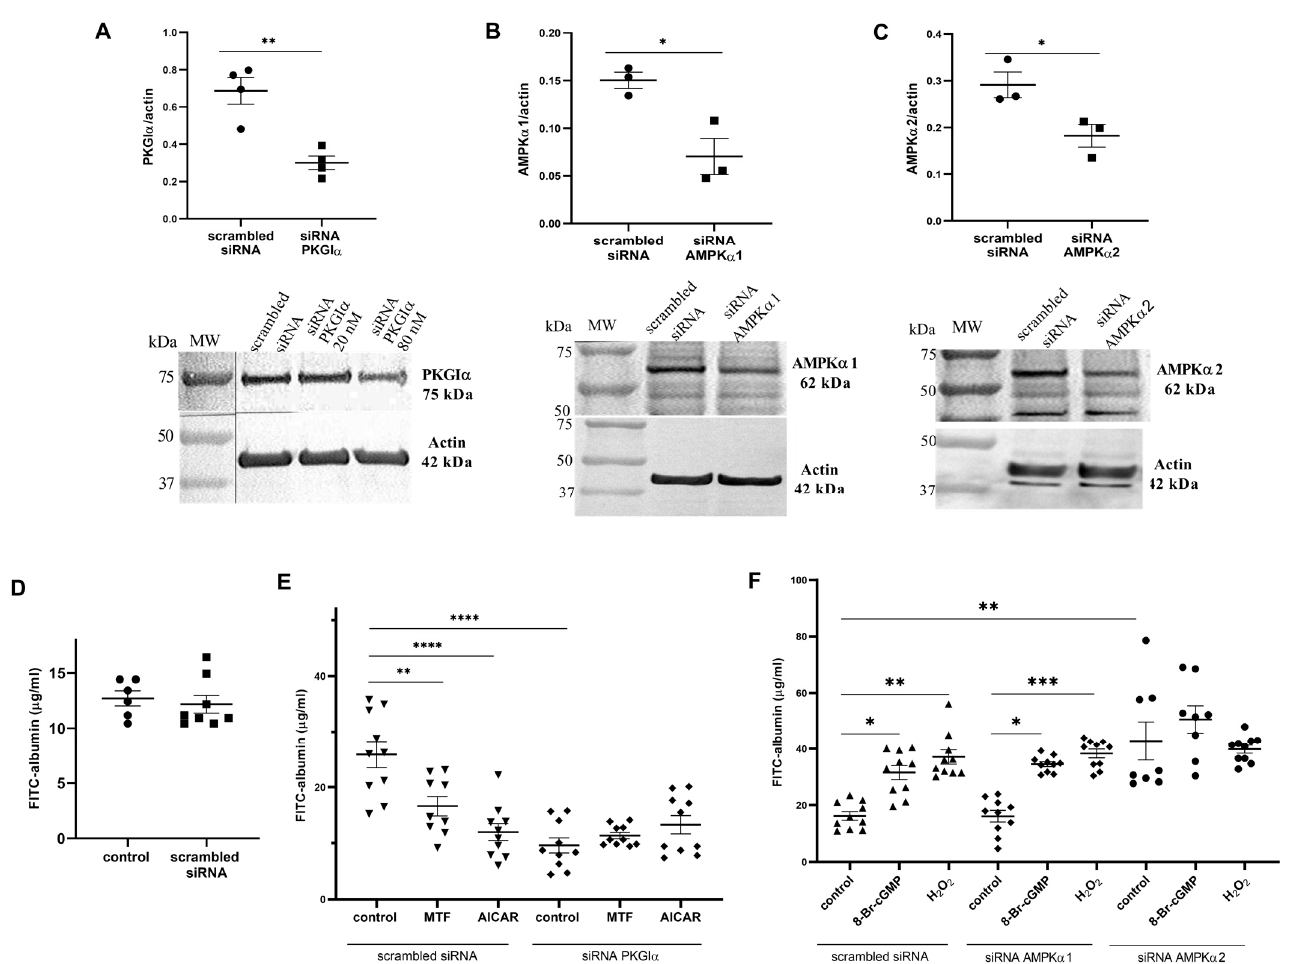
Figure 2. Opposite effects of PKGI α and AMPK α on albumin permeability across the podocyte monolayer. ( A – C ) Effects of PKGI α ( A ), AMPK α 1 ( B ), and AMPK α 2 ( C ) gene-silencing on protein ex- pression in cultured rat podocytes; ( D ) Effect of scrambled siRNA on podocyte albumin permeability; ( E ) Effect of PKGI α siRNA on podocyte albumin permeability in the presence of the AMPK activators MTF (2 mM, 2 h) and AICAR (100 µ M, 2 h); ( F ) Effect of AMPK α 1 and AMPK α 2 gene-silencing